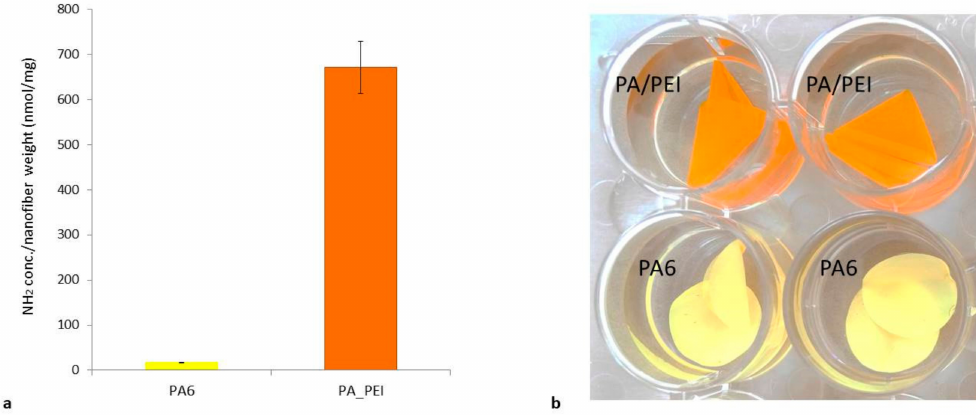
Figure 2. Quantification of available amino groups of polyamide 6 (PA6) and polyamide 6 / polyethylenimine (PA / PEI) nanofibers ( a ). Color di ff erence according to the amount of methyl orange (MO) attached to the nanofibers ( b